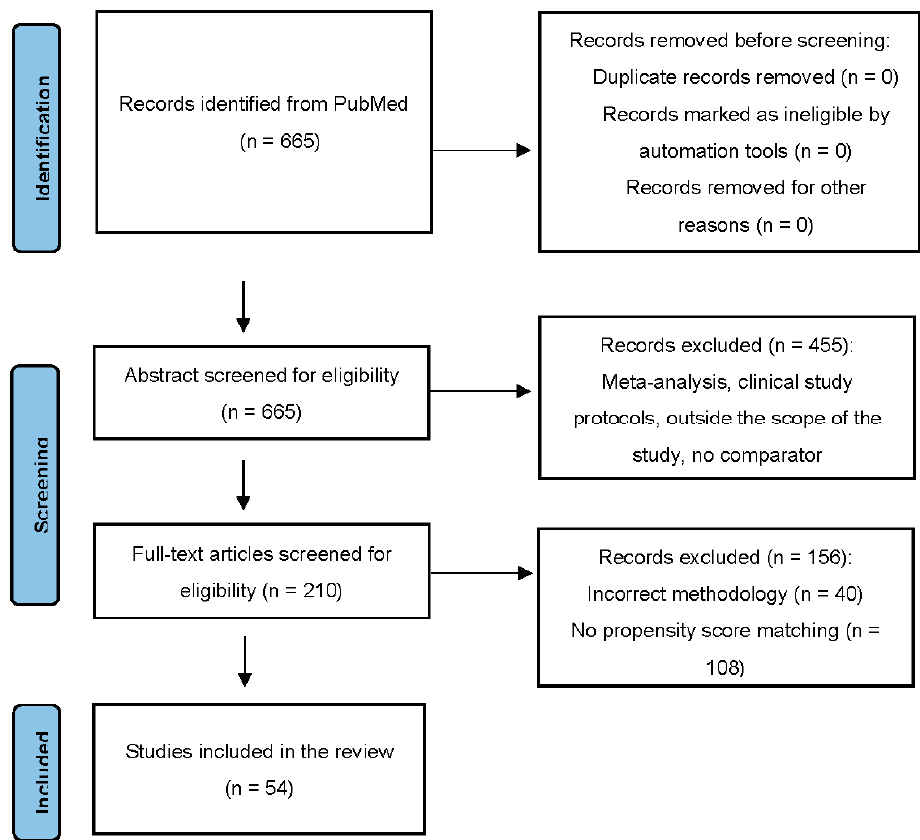
Figure 1. Preferred Reporting Items for Systematic Reviews and Meta-Analyses (PRISMA) flow chart of the study selection process. Table 1. Study characteristics.